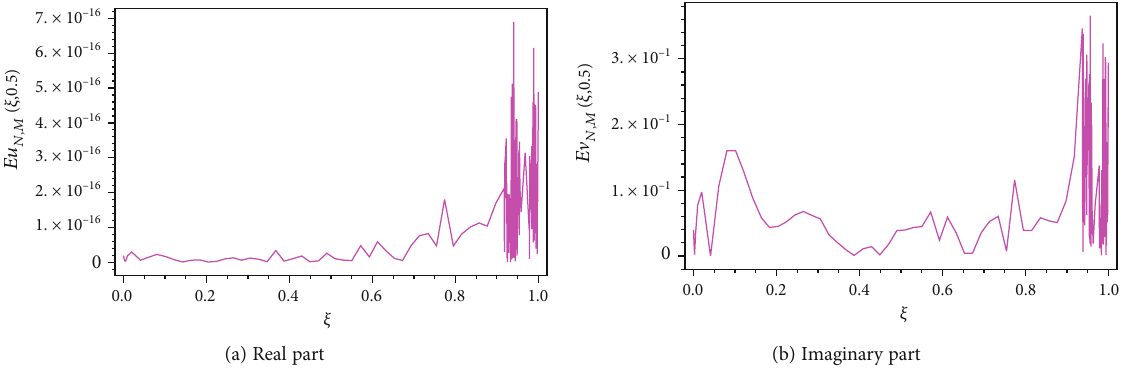
Figure 3: ξ -direction curves of real and imaginary parts of the absolute error of Equation